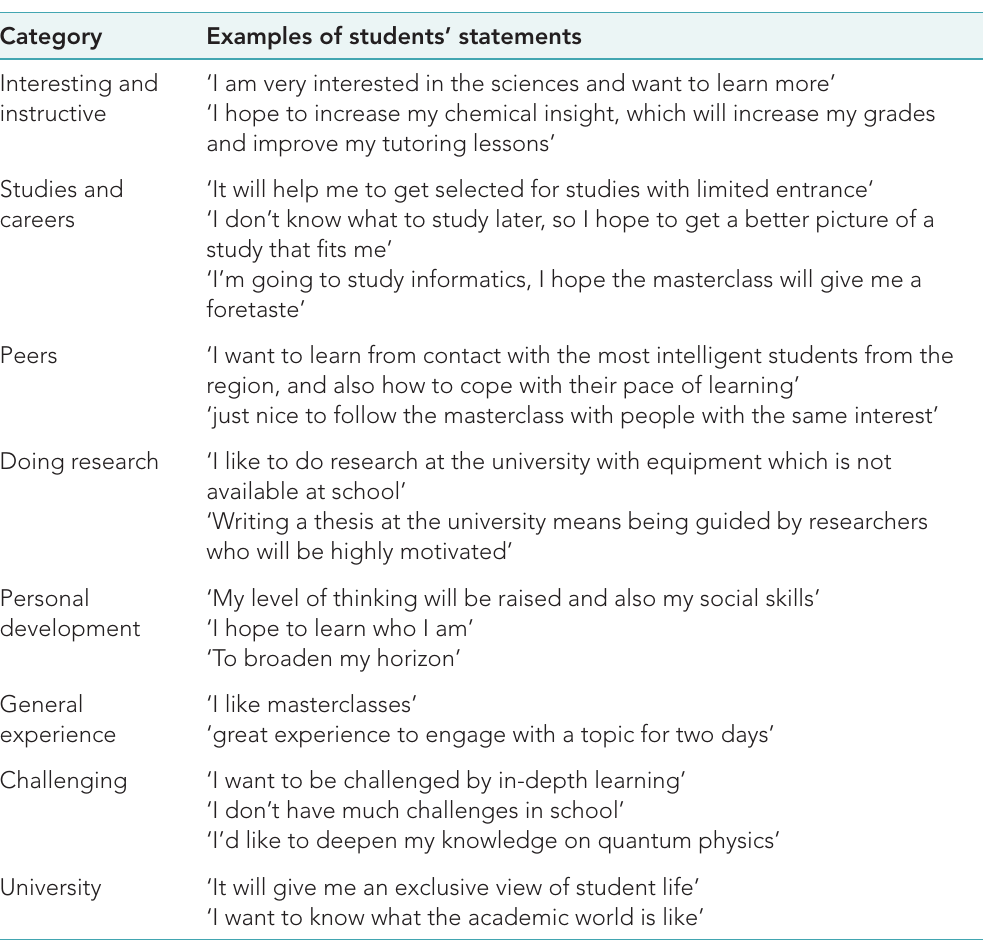
Table 5a: Examples of students’ motivational statements, based on open questions before UTA and